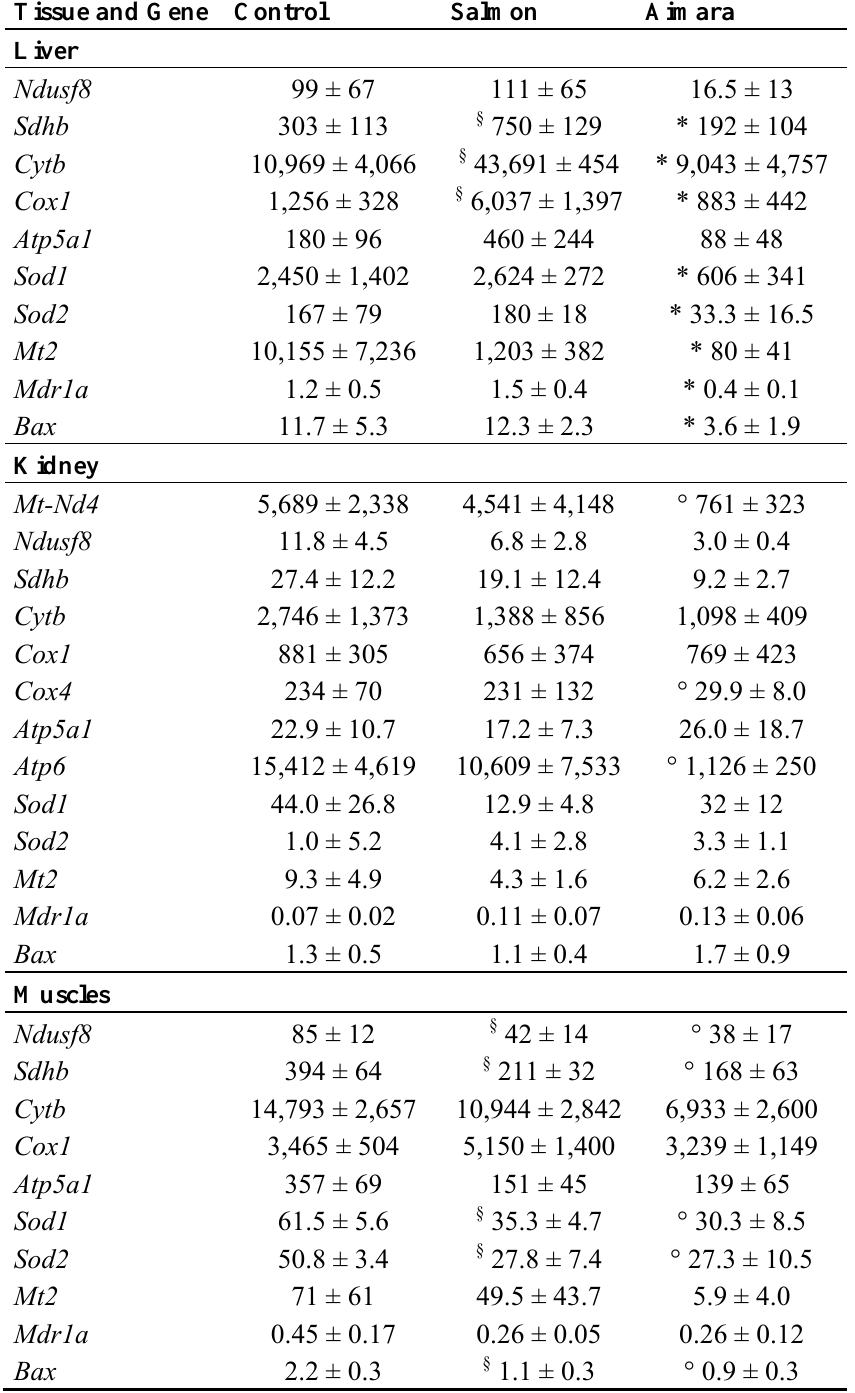
Table 8. Gene expression in tissues from wild-type mice fed fish-containing diets for three months a